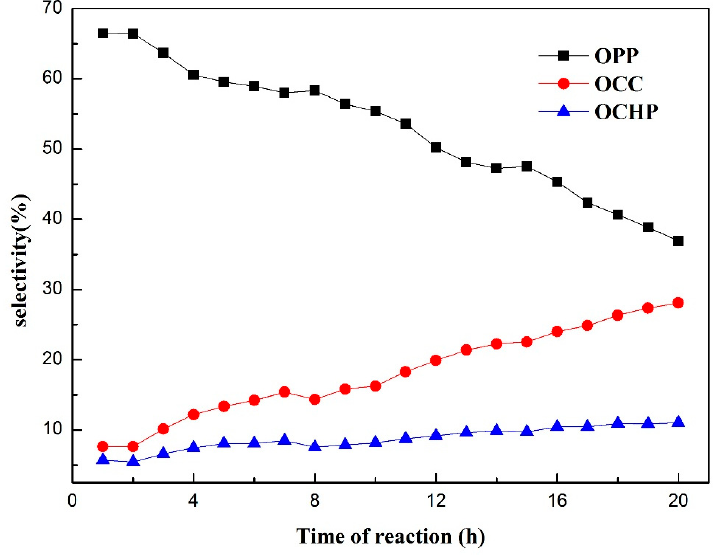
Figure 10. Stability test on CNMA-4 at 330 °C for 20 h.